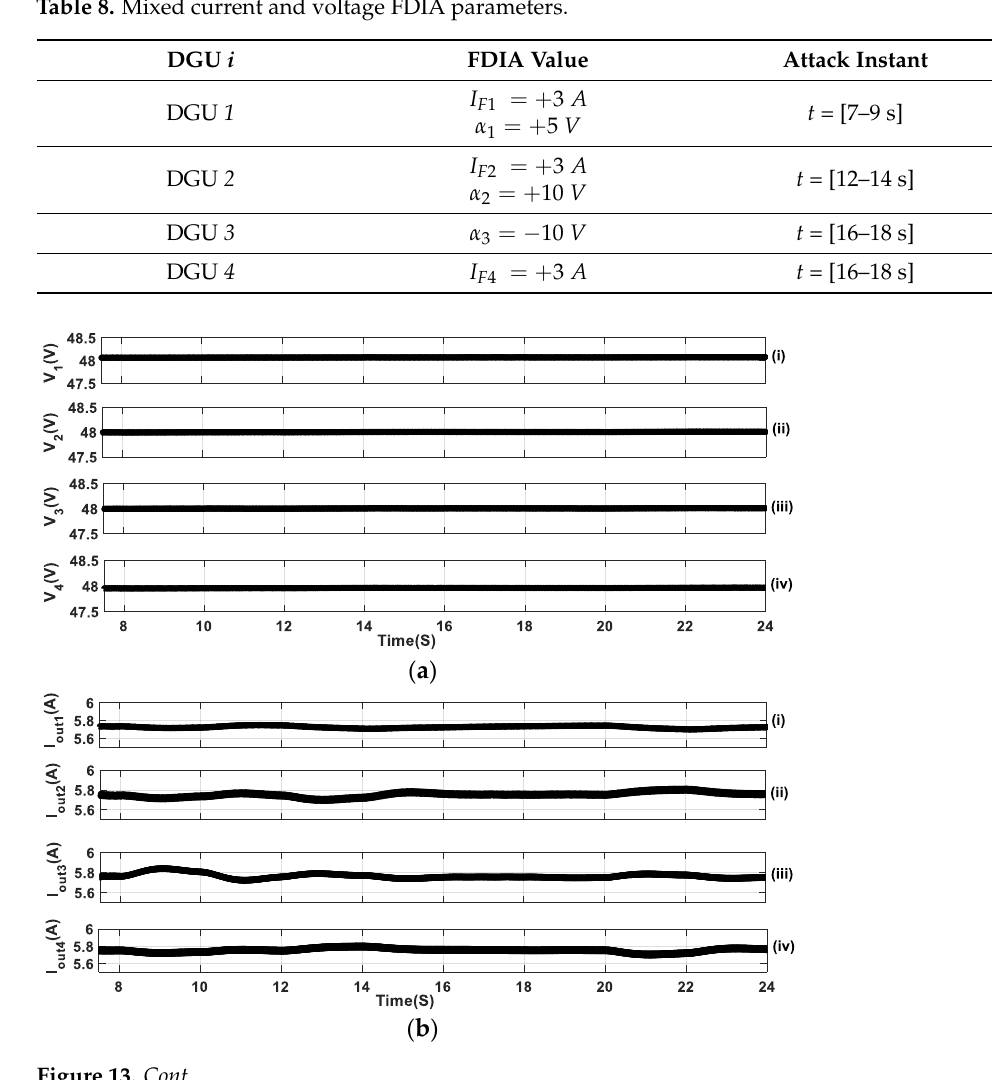
Table 7. Sequential current FDIA parameters.